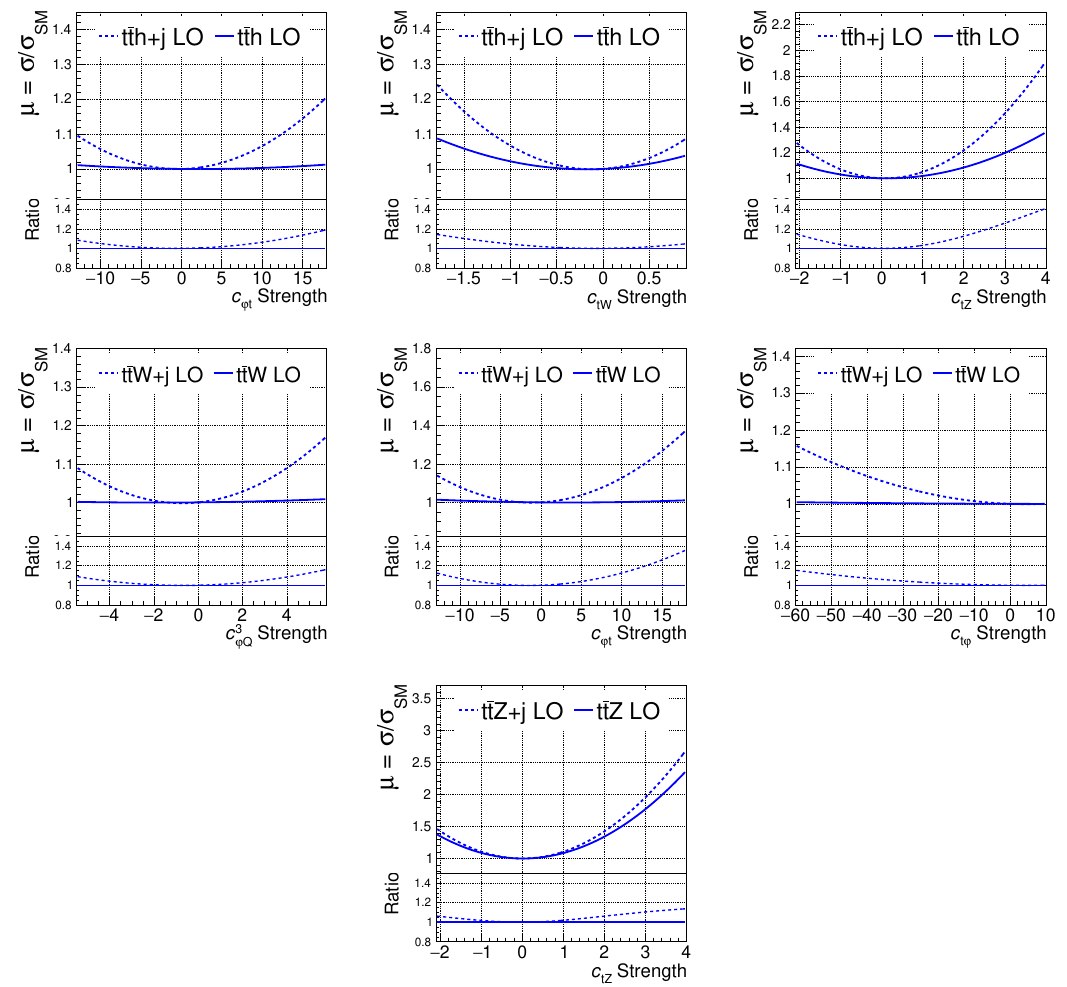
Figure 10 . Inclusive cross section for t¯th , t¯tW , and t¯tZ (with and without an additional parton) as a function of the Wilson coefficient. The y axis shows the ratio of the EFT prediction to the SM. The quadratic parameterizations are generated by fitting a quadratic function to inclusive cross sections calculated at a number of different Wilson coefficient values; the MC statistics are sufficiently large such that the statistical error on the fitted curves is negligible. The ratio plots show the µ / µ ratios. As described in the text, the range for each Wilson coefficient is taken t¯tX+j t¯tX from the marginalized limits presented in ref.